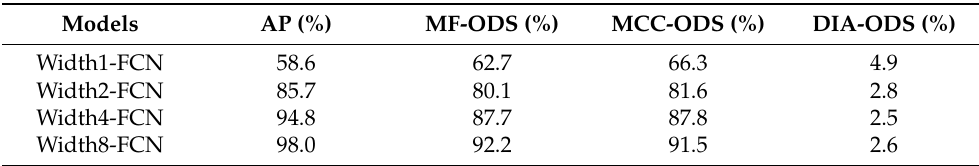
Figure 13. The performances of FCN models trained on labels with different contour widths. Table 4. The mean values of evaluation metrics computed from FCN models trained on labels with different contour widths.